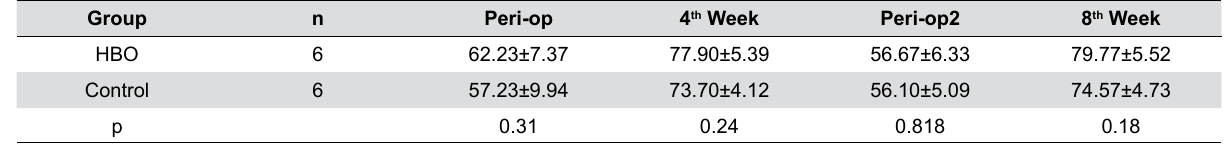
Table 1- Comparison of RFA values between groups and according to different healing time points. Data is displayed as mean±SD